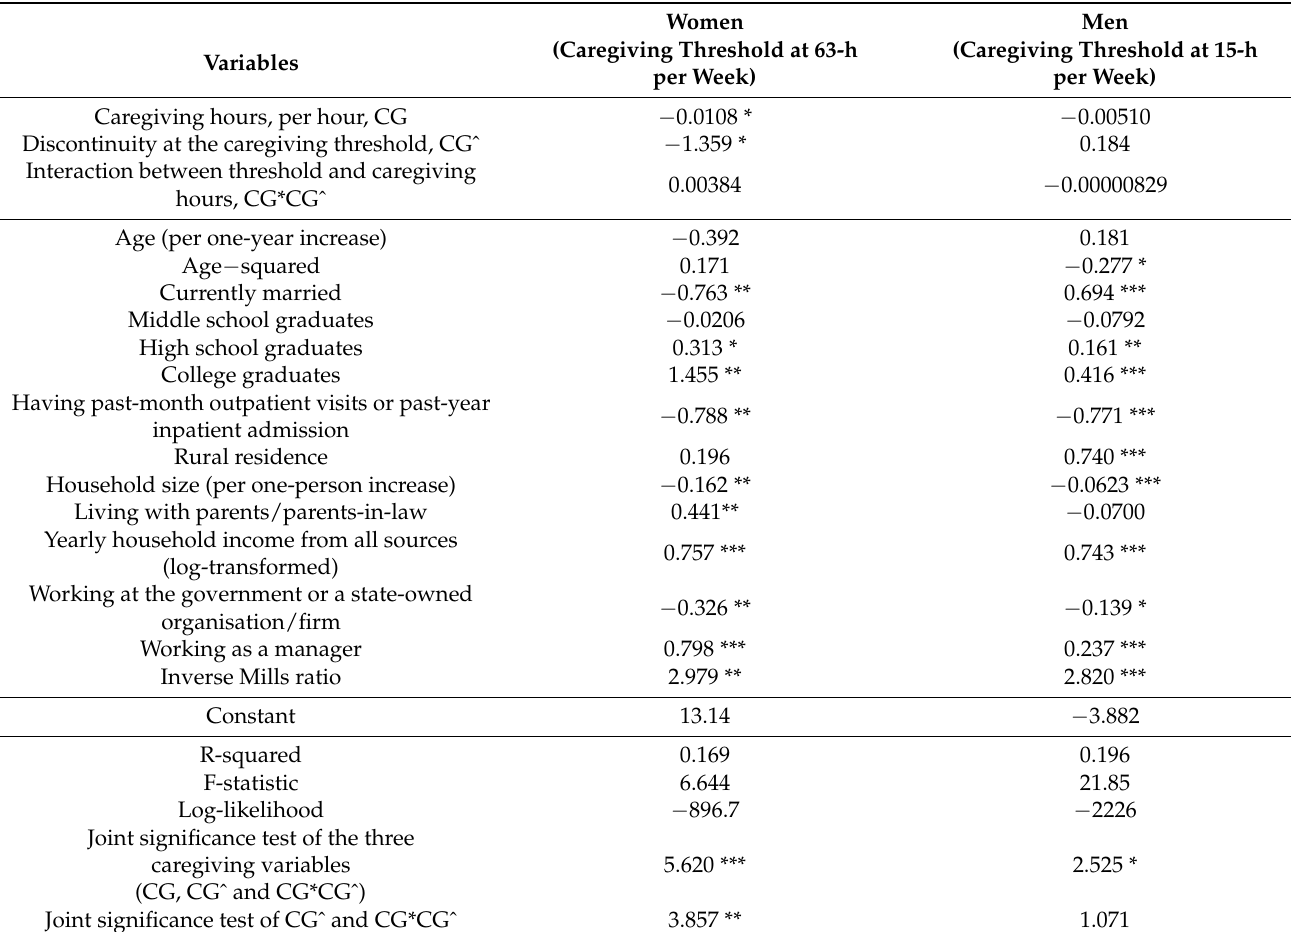
Table 3. Results of the Heckman selection model predicting log-transformed monthly employment